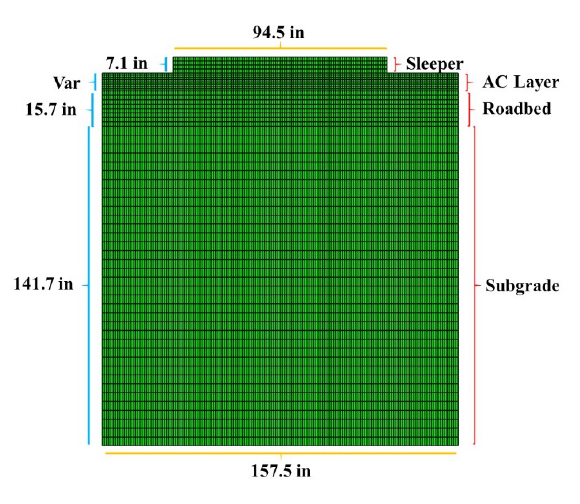
Figure 4: Asphaltic overlayment trackbed.